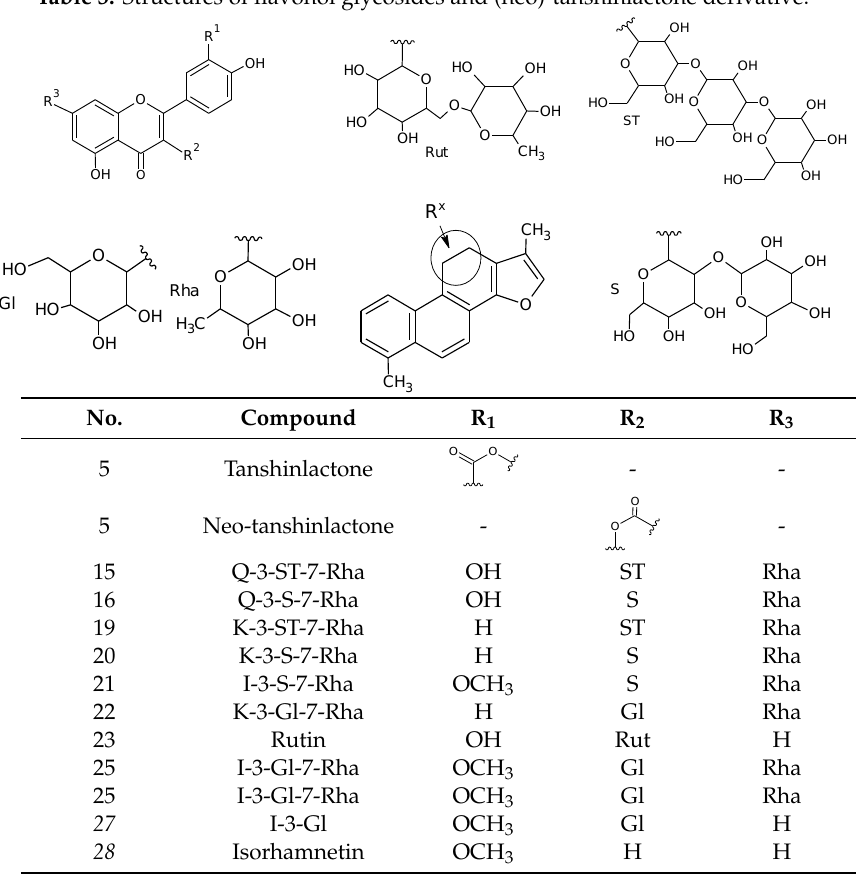
Table 4. Quantification of phytochemicals, in μg/g DWE and μg/g DWP. Peak No.